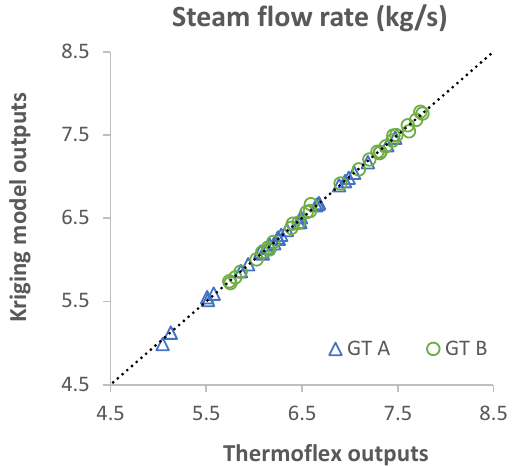
Figure A1. Parity plot of the net cycle efficiency for Kriging model validation.